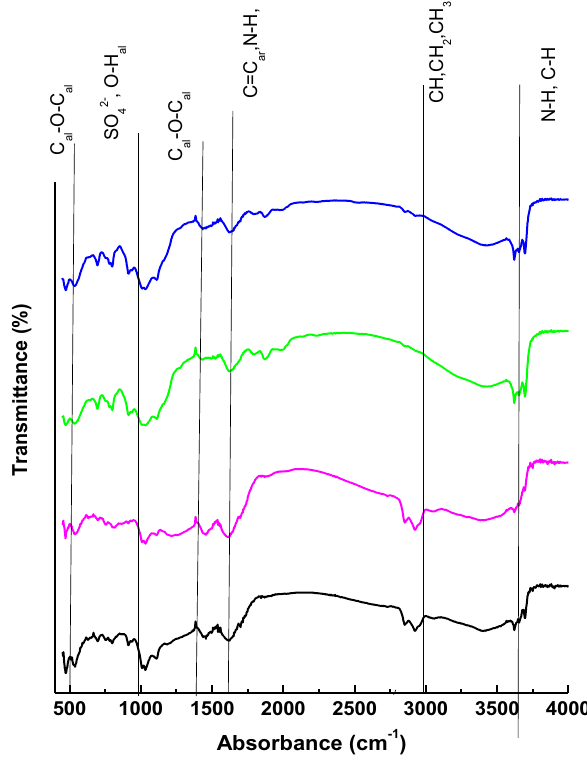
Fig. 32 FT-IR spectra for raw coal and OB of Ledo colliery